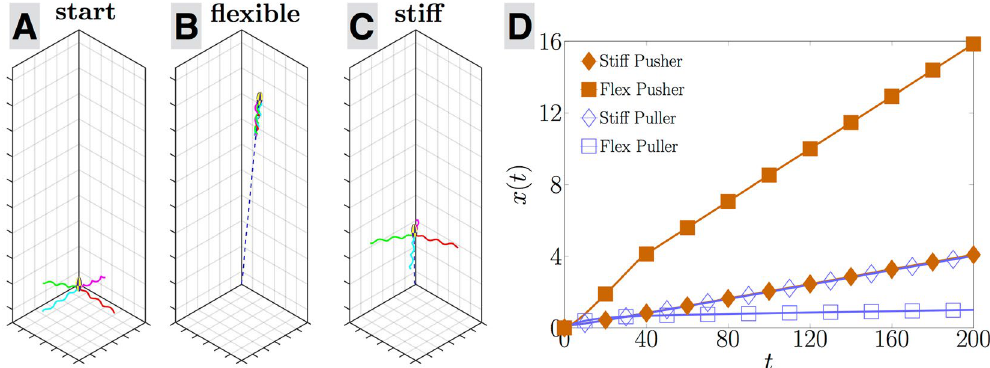
Figure 3. Swimming motion for a bacterium swimming with N f = 4 flagella with a flexible vs. stiff hook. ( A ) Initial position and conformation of each cell. ( B ) Pusher cell with flexible hook at t = 200 (times scaled by rotation rate of flagella). ( C ) Pusher cell with stiff hook at t = 200. ( D ) Distance travelled by each swimmer (nondimensionalised by the pitch of the helical filaments) as a function of time for four different swimmers: stiff (diamonds) vs. flexible hook (squares) and pusher (filled symbols) vs. puller